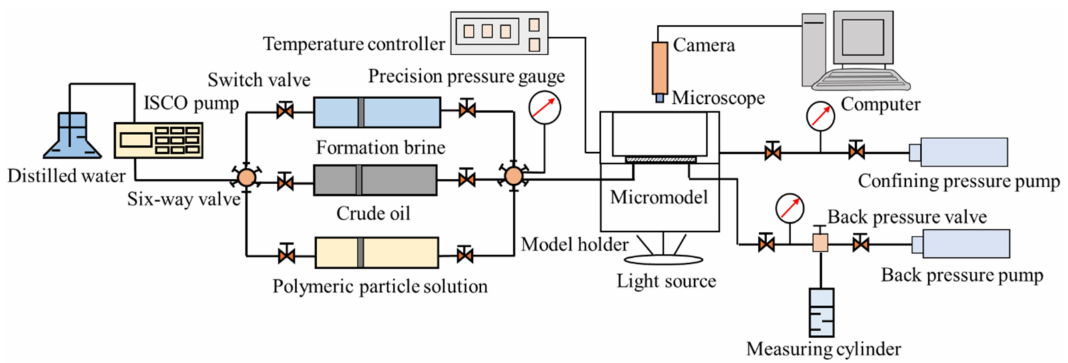
Figure 6. Schematic diagram of the microscopic flooding experiment. The experimental setup included the flooding and image capturing systems. The flooding system comprised a syringe pump; three accumulators to store the formation brine, crude oil, and polymeric particles solution; a stainless steel model holder that was a hollow cylinder with glass windows at the bottom and top; a micromodel that was clamped horizontally by the thick glass cover inside the model holder; a temperature controller to regulate the temperature inside the model holder; a confining pressure pump to load the pressure around the micromodel through injecting water into the model holder; a backpressure valve to simulate the actual formation pressure; and a back pressure pump to load the reverse pressure for the backpressure valve. The image capturing system consisted of a light source to penetrate vertically through the micromodel, a camera, a microscope, and a